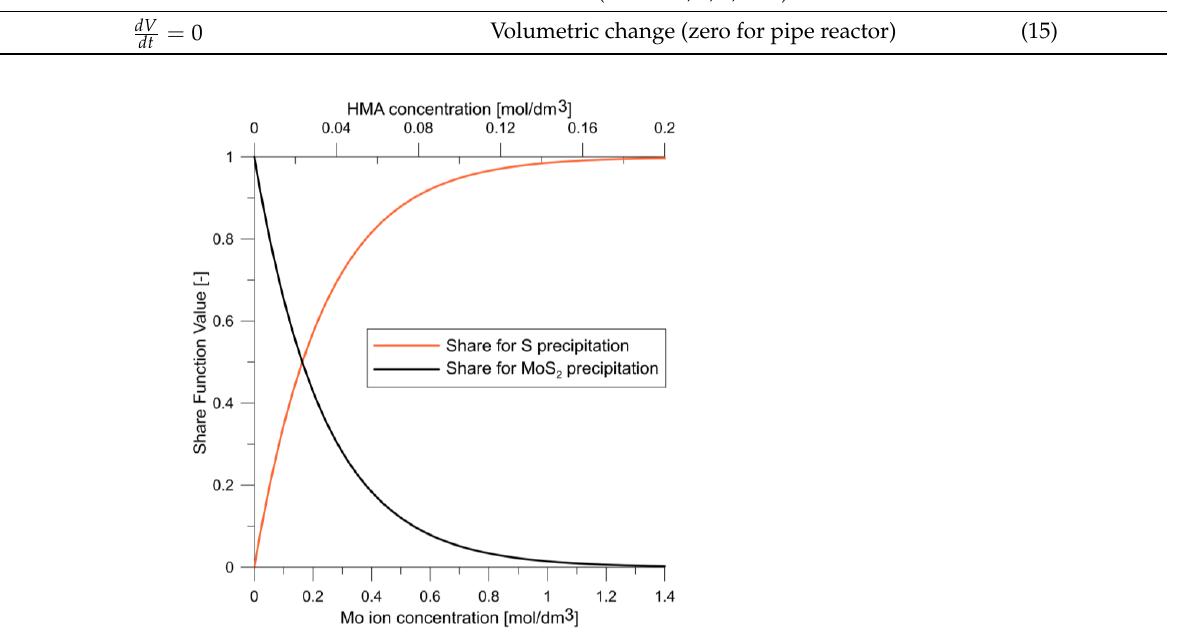
Figure 2. Share function values for a given model.